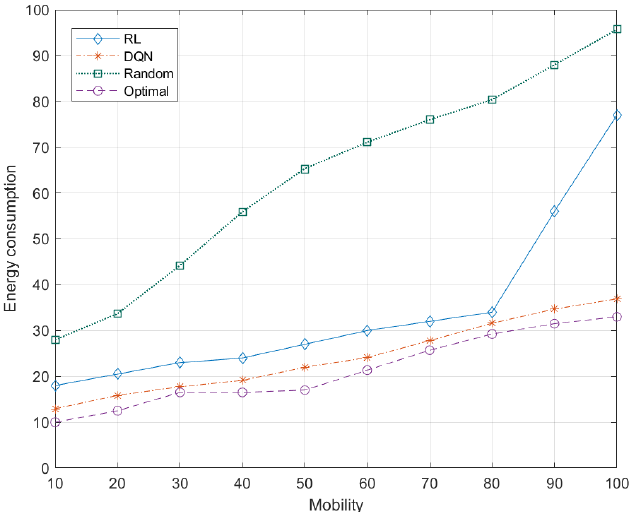
Figure 12. Energy consumption increases with respect to mobility rate. DQN achieves lower values as compared to RL and random approaches. Lower energy consumption improves the energy efficiency of a